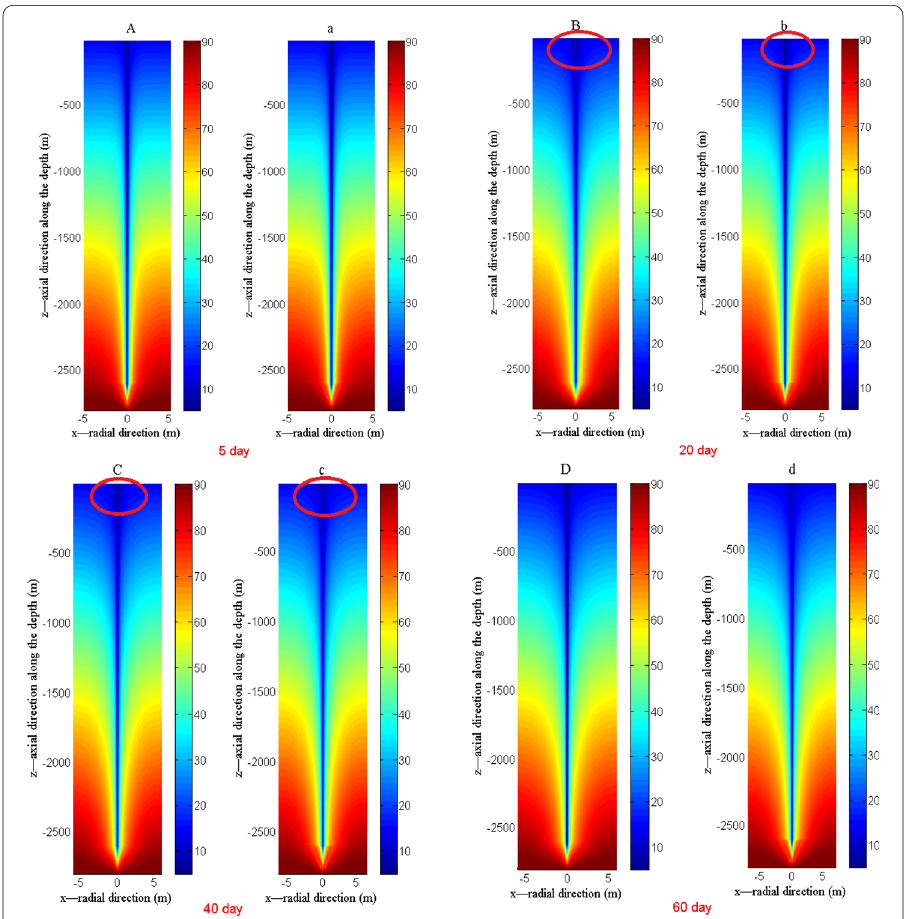
Fig. 15 Rock temperature distribution underground during the heating season. A , B , C , D depict the simulation results at 5, 20, 40, and 60 days from the proposed efficient modeling in the paper, respectively. a , b , c , d show the corresponding results from the detailed simulation. Rock temperature unit is °C in the color